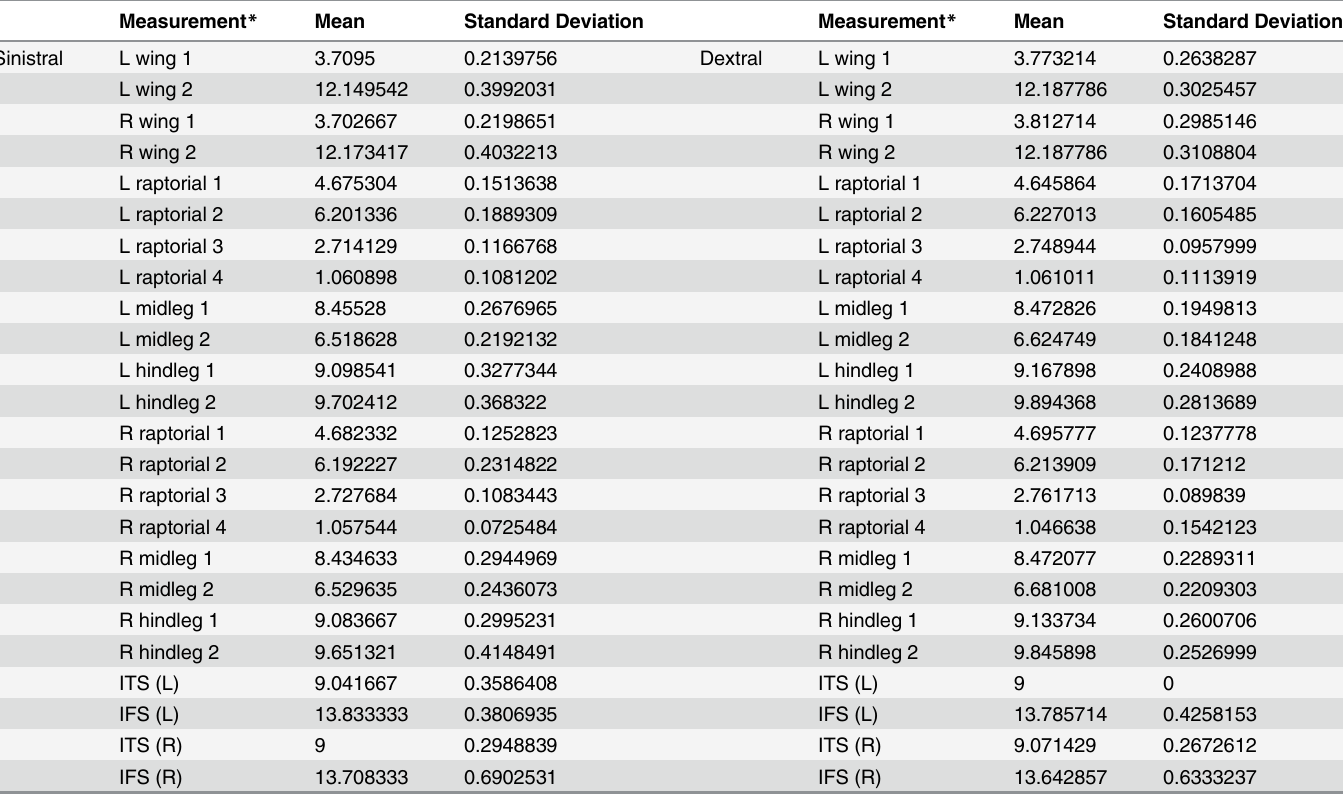
Table 1. Summary of means and standard deviations of 24 morphological measurements for males of sinistral and dextral genital orientation. Measurement